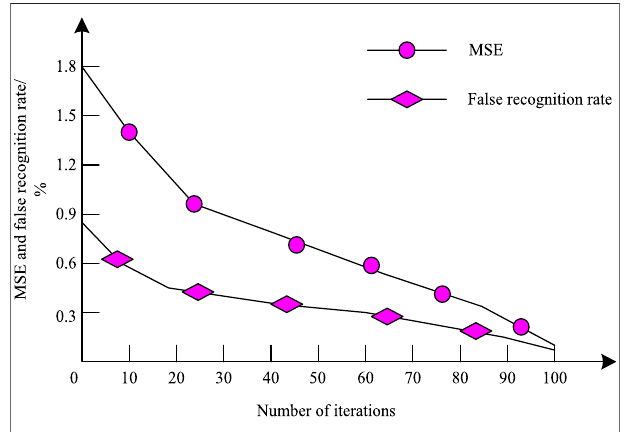
FIGURE 4 | 3D convolutional cloud neural network training results.